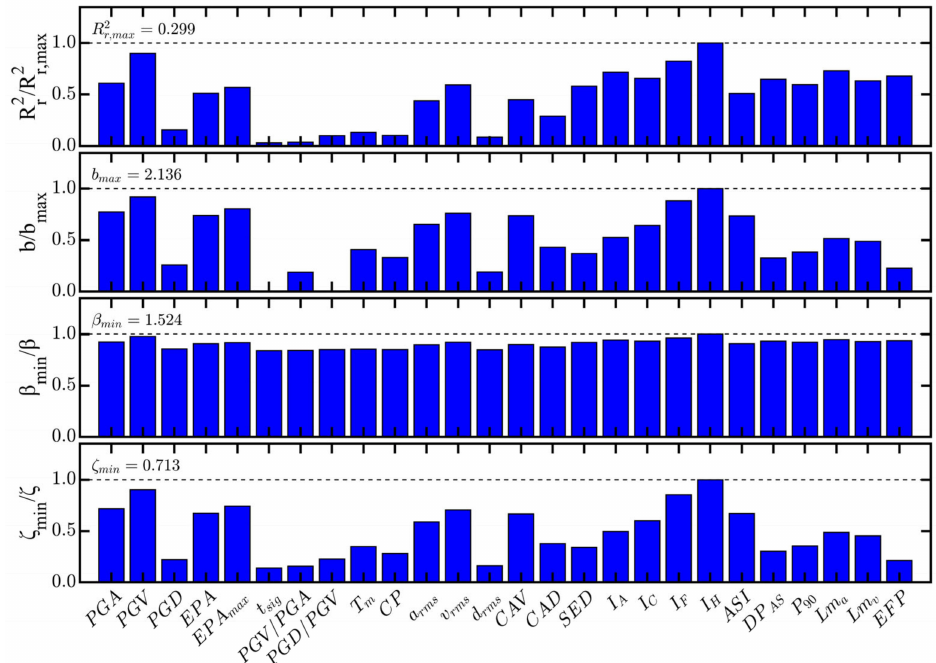
Figure 3. Performance evaluation of conventional IMs in developing